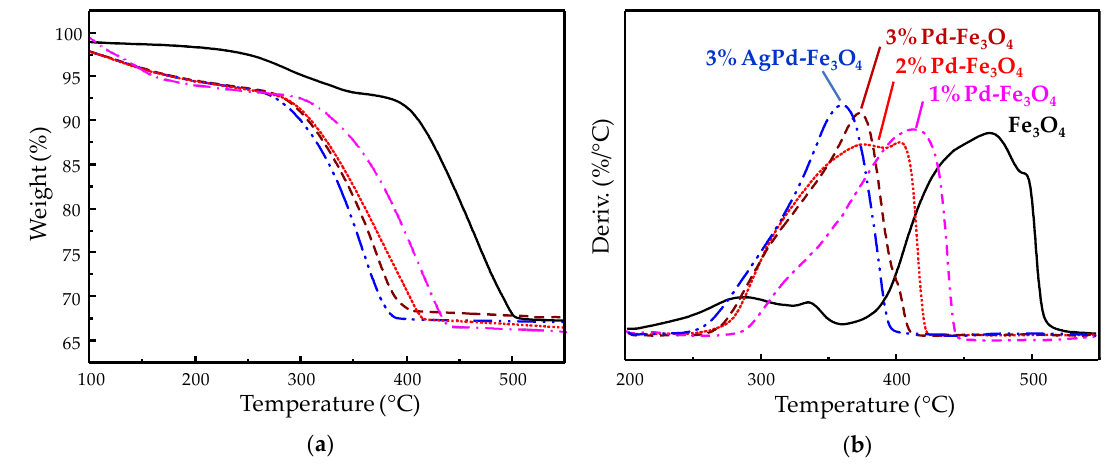
Figure 8. Thermogravimetry analysis curves collected in H 2 for the di ff erent (Ag)Pd-Fe 3 O 4 catalysts